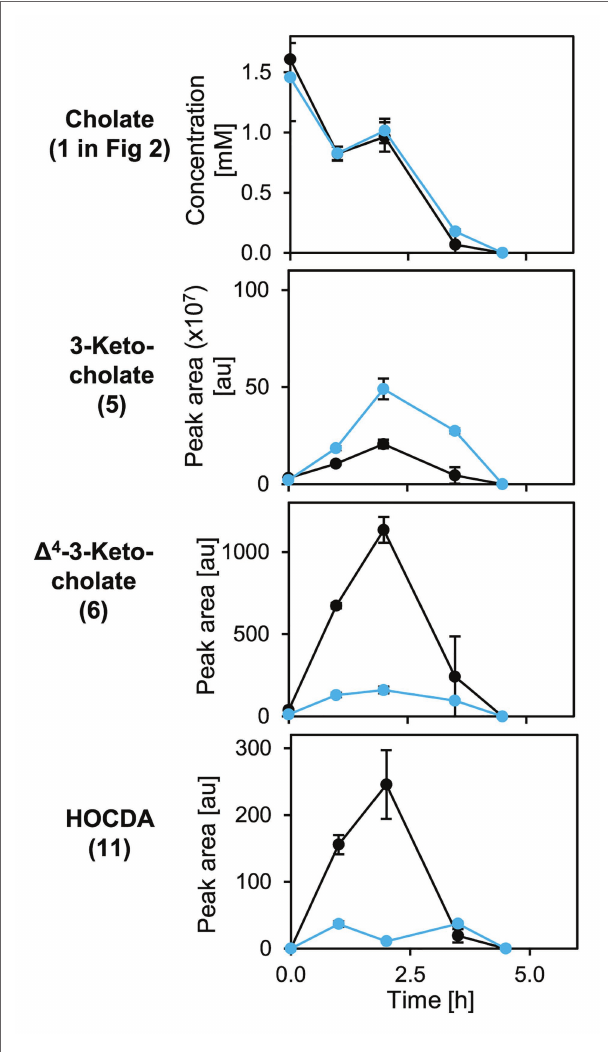
FIGURE 8 | Degradation of cholate ( 1 in Figure 2 ) by suspensions of glucose- grown cells of Sphingobium sp. strains Chol11 wt (black) and Δ 5 β -Δ4-kstd1 (blue; OD 600 = 1) and transient accumulation of intermediates 3-ketocholate ( 5 ), Δ 4 -3-keto-cholate ( 6 ), and HOCDA ( 11 ) in the cell-free culture supernatant. Error bars indicate SD, which may not be visible if too small ( n =